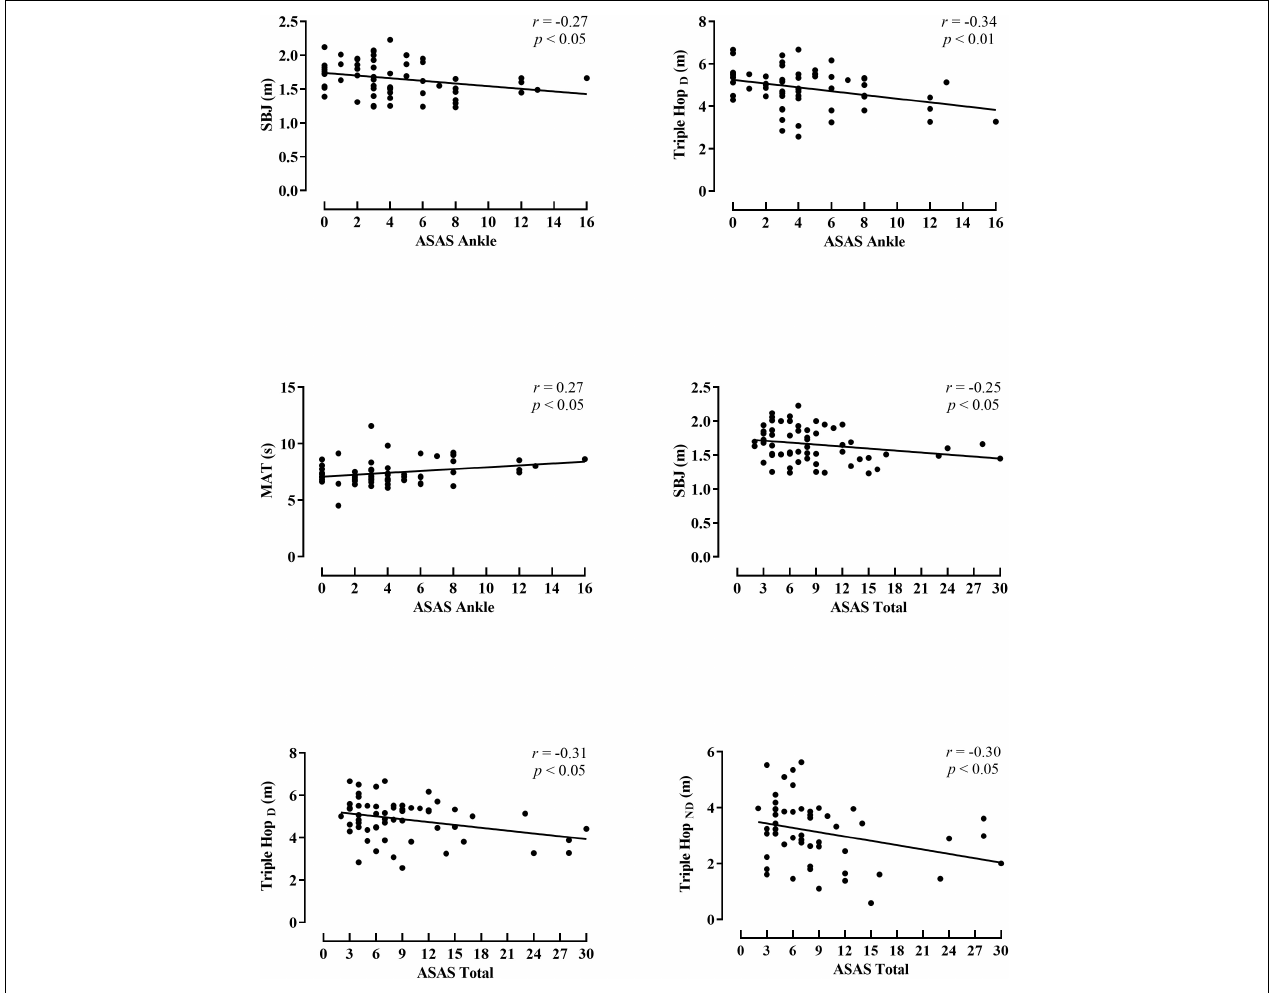
FIGURE 2 | Pearson product correlation between scores for the Australian Spasticity Assessment Scale (ASAS) in ankle muscle group, and total score with activity limitation test performance by all para-footballers. SBJ, standing broad jump; TH D , triple hop for distance dominant leg; TH ND , triple hop for distance non-dominant leg; MAT, modified agility